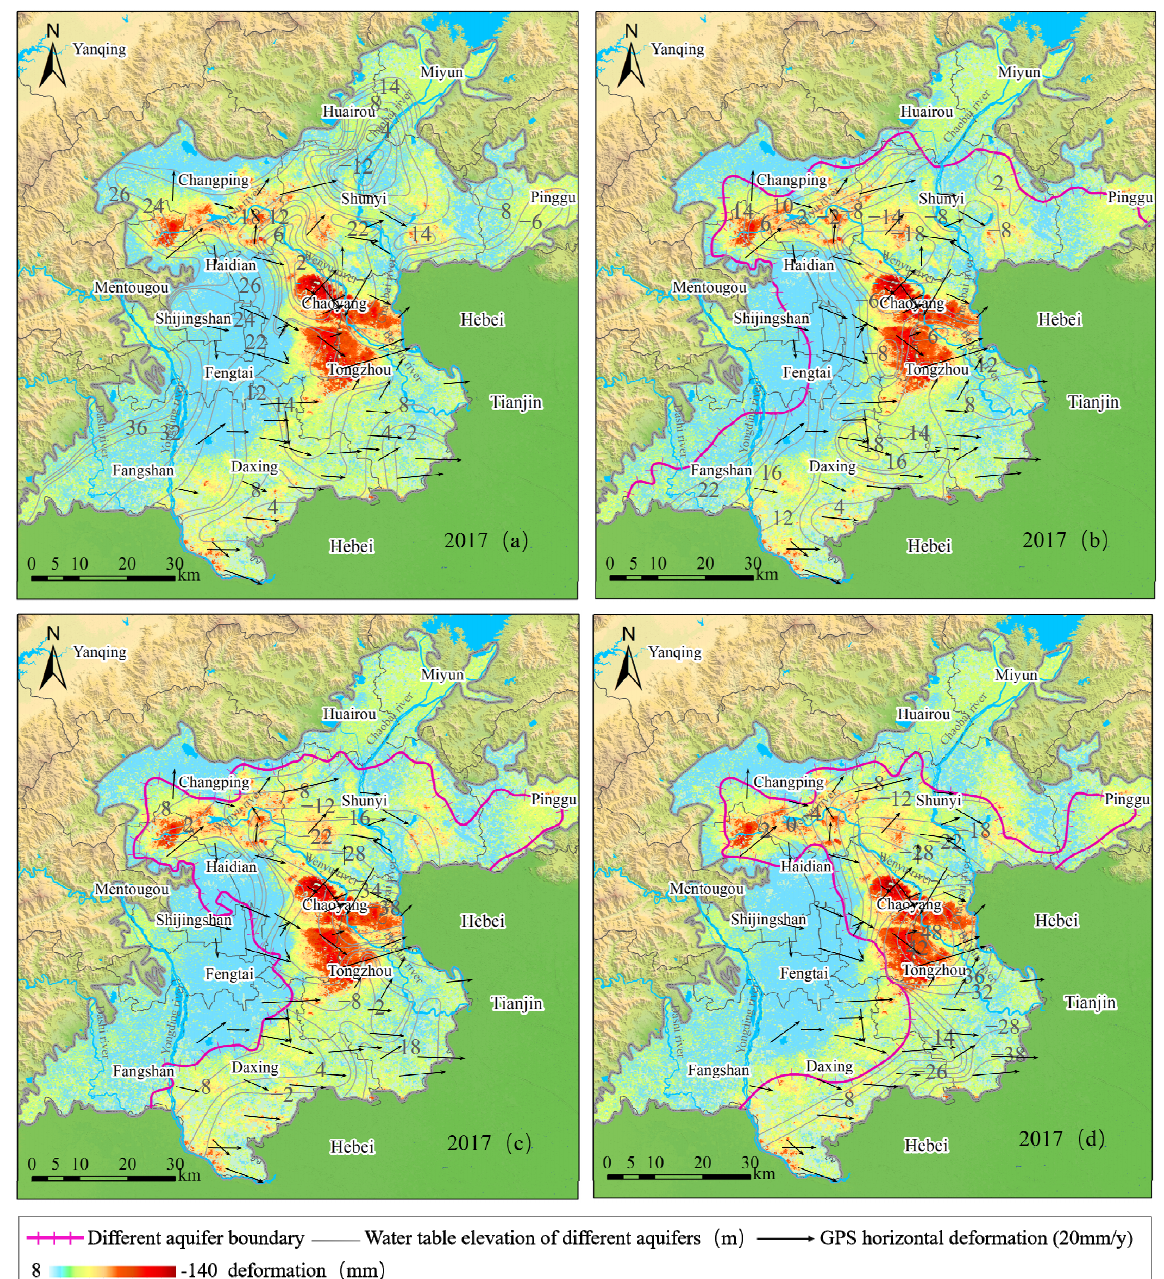
Figure 15. The relationship between the groundwater funnel and the 3D deformation of the land surface. ( a ) Unconfined aquifer. ( b ) First confined aquifer. ( c ) Second confined aquifer. ( d ) Third confined aquifer.